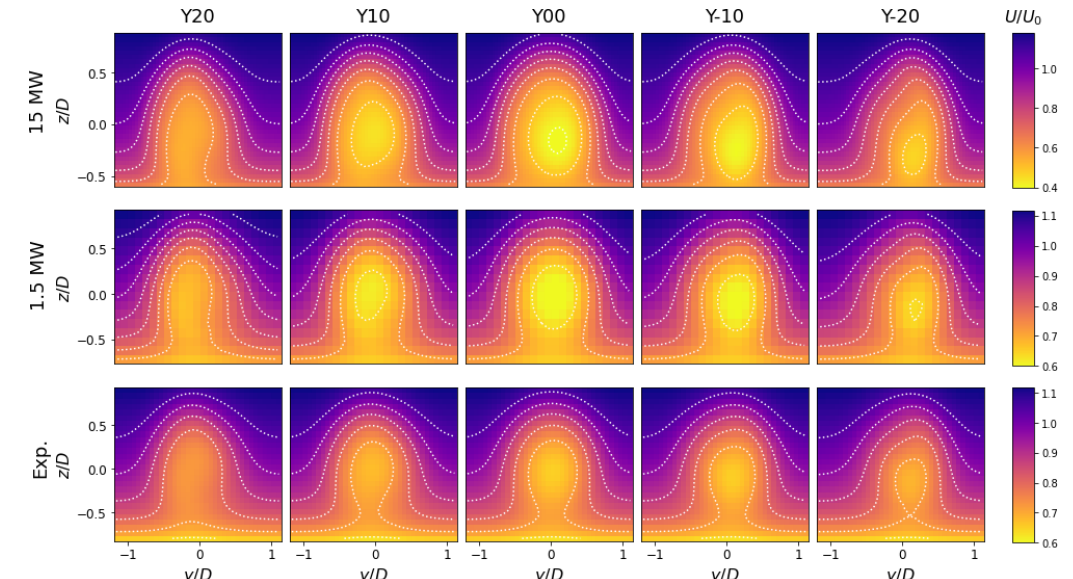
Figure 8. FLORIS streamwise flow fields across yaw angles at x/D = 3 for 15MW (top panels), 1.5MW (middle panels), and scaled model turbine (bottom panels) inputs. Wake deformation is visible for yawed cases since the curled wake model includes the counter-rotating vortex